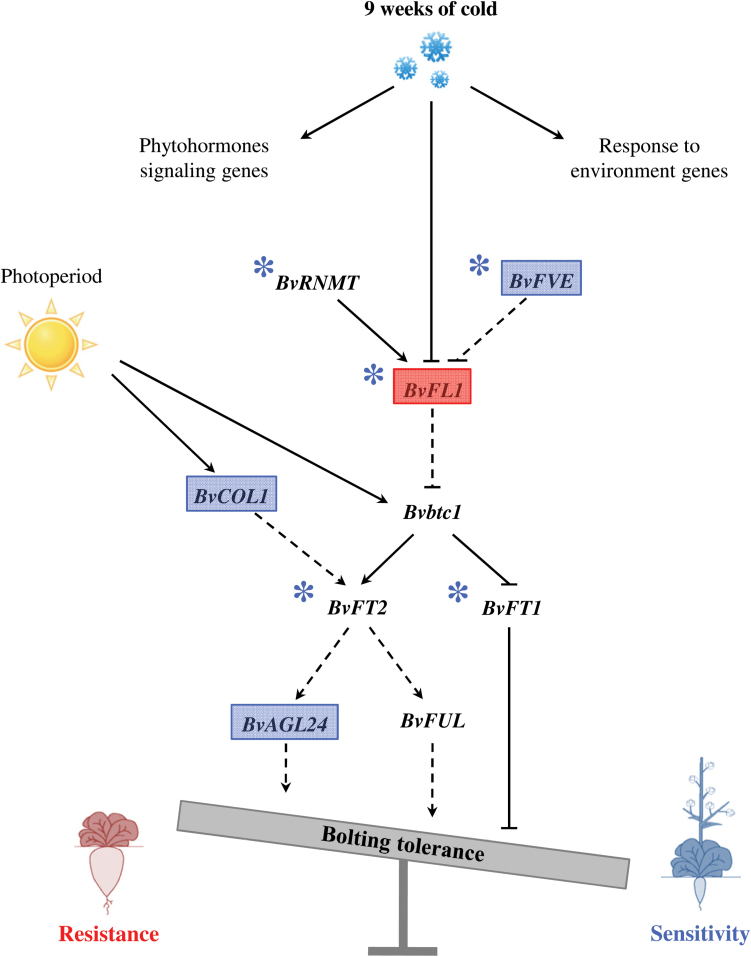
Bolting/flowering model in sugar beet. BvAGL24, AGAMOUS-LIKE 24; Bvbtc1, bolting time control 1; BvCOL1, CONSTANS-LIKE 1; BvFL1, FLOWERING LOCUS C; BvFT1 andt BvFT2, FLOWERING LOCUS T 1 and 2; BvFVE, FLOWERING LOCUS VE; BvFUL, FRUITFUL; BvRNMT, RNA METHYLTRANSFERASE. Arrows and a dotted line indicated a hypothetical control based on the Arabidopsis flowering pathway. Genes coloured in blue are floral inducers overexpressed in bolting-sensitive genotypes. BvFL1, in red, is a floral inhibitor overexpressed in bolting-resistant genotypes. Asterisks (*) indicate hypermethylated genes in bolting-sensitive genotypes.